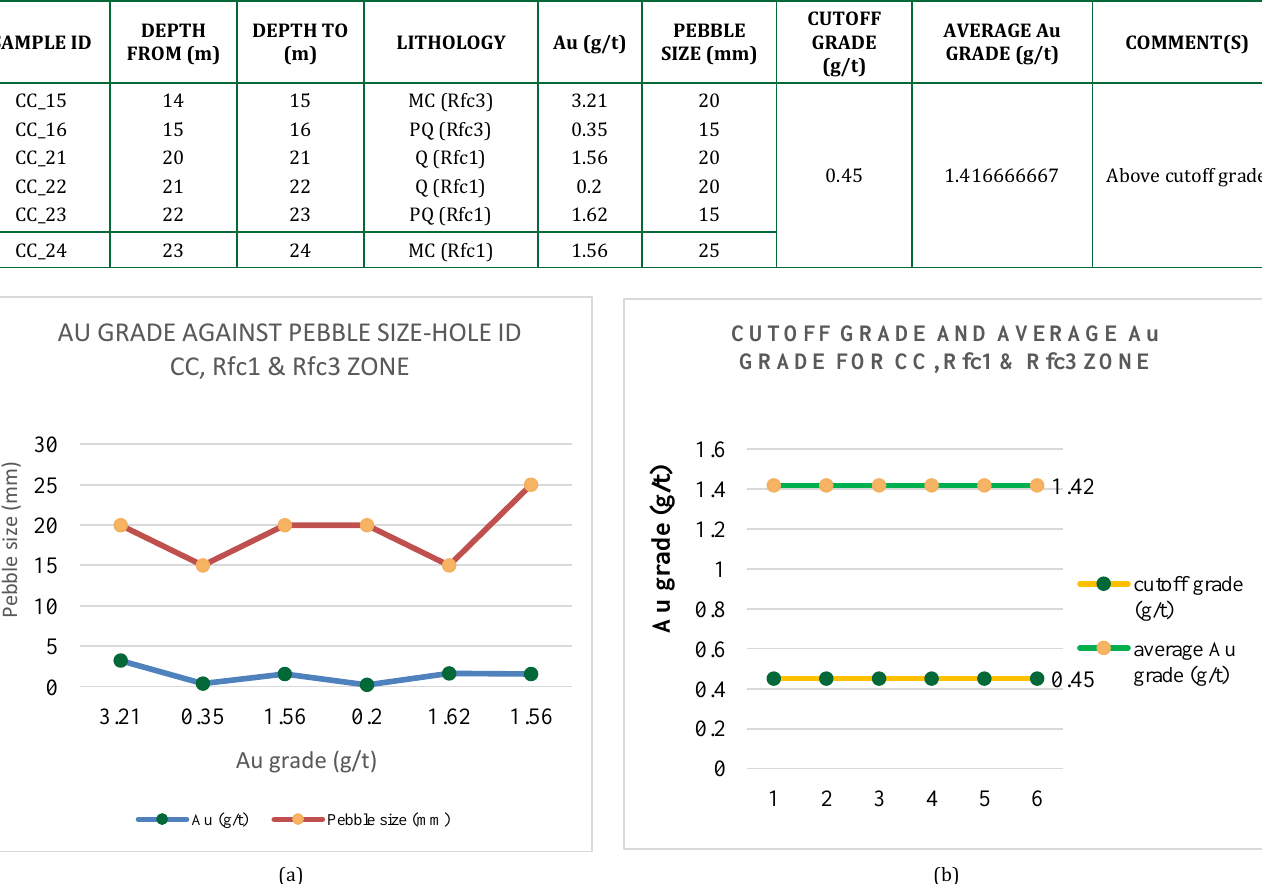
Table 9: Analysis of Hole Id Cc, Rfc3 & Rfc1 Zone